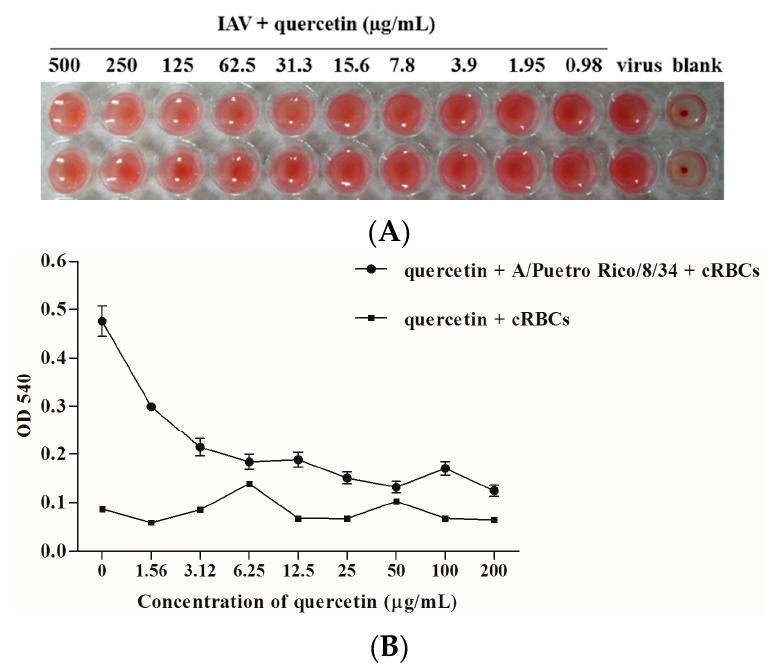
Figure 6. ( A ) Hemagglutinin inhibition assay for quercetin. 4HAU influenza A/Puerto Rico/8/34 (H1N1) virus was incubated with serally diluted quercetin at room temperature for 30 min. 0.5% cRBCs was added, and the virus then incubated at room temperature for 1 h. Note the inhibition on hemagglutination of quercetin; ( B ) Hemolysis inhibition assay of quercetin against the influenza A/Puerto Rico/8/34 (H1N1) virus strain. Quercetin diluted in PBS was mixed with an equal volume of the influenza virus A/Puerto Rico/8/34 (H1N1) in a 96-deep well plate. After incubating at room temperature for 30 min, 2% chicken erythrocytes pre-warmed at 37 ˝ C were added. The mixture was incubated at 37 ˝ C for another 30 min. To trigger hemolysis, sodium acetate (0.5 M; pH 5.0) was added and incubated at 37 ˝ C for 15 min. Plate was centrifuged at the end of incubation at 3000 rpm for 5 min, and the supernatants were transferred to another flat-bottom 96-well plate. The OD 540 was read on a microtiter plate